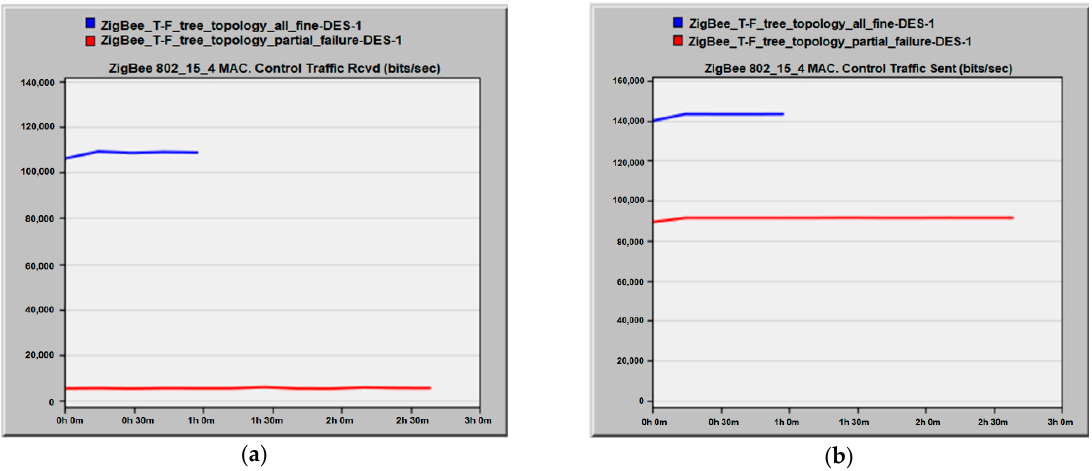
Figure 6. ( a ) Data received in bits per second; ( b ) Data sent over the network in bits per second.